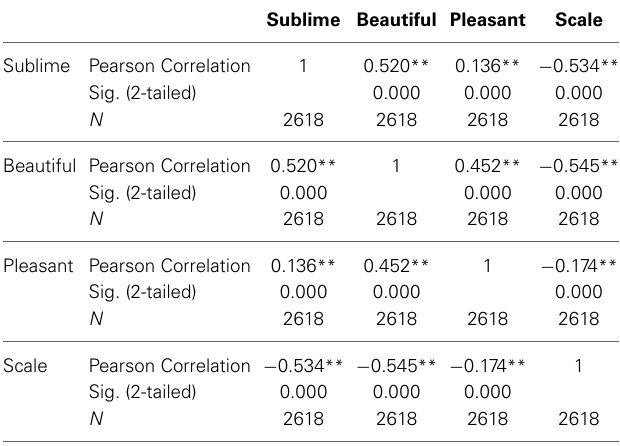
Table 1 | The results of correlation analyses derived from the behavioral data over 21